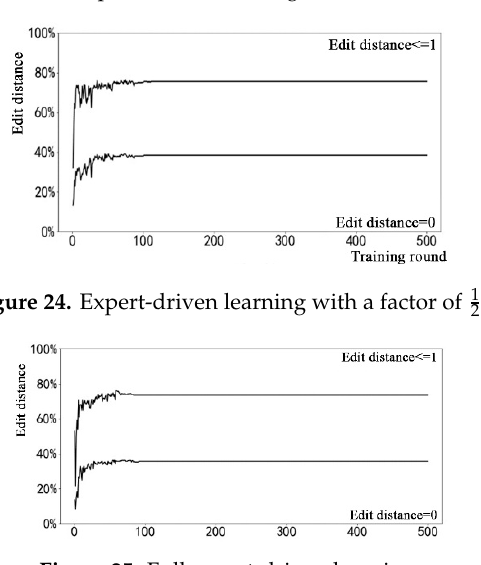
Figure 23. Expert-driven learning with a factor of 2/3.